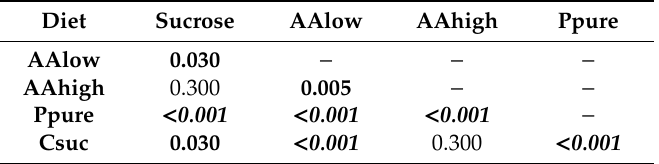
Figure 2. Survival probability of bumble bees (N = 50 per treatment) kept in micro-colonies fed pure pollen (Ppure), casein-sucrose (1:3, Csuc), only sucrose solution (60% by mass, Sucrose), 60% sucrose solution with concentrations of essential amino acids and proline (AAlow), and 60% sucrose solution with amino acids at a 100 times higher concentration (AAhigh). Table1. Di ff erencesinlongevityofbumblebeeskeptinmicro-coloniesfeddi ff erentdiets. P -values < 0.05 are marked in bold. P -values that are significant after Bonferroni correction are additionally marked in italics. Abbreviations as follows: Pure pollen (Ppure), casein-sucrose (Csuc), only sucrose solution (60% by mass, Sucrose), 60% sucrose solution with natural concentrations of essential amino acids and proline (AAlow), and 60% sucrose solution with amino acids at a 100 times higher concentration